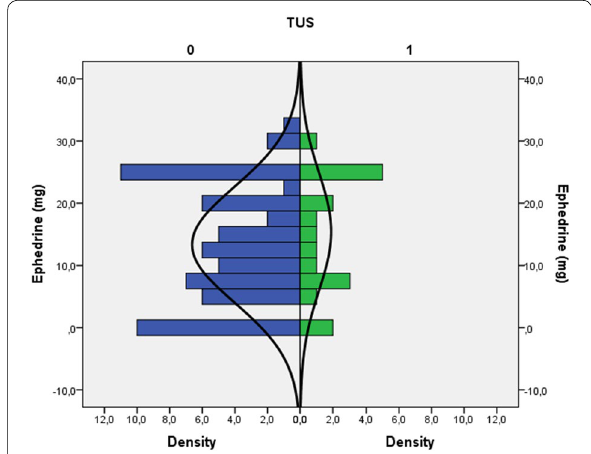
Fig. 2 Distribution of the amount of ephedrine in the study population divided for the presence or absence of at least one area with B-lines